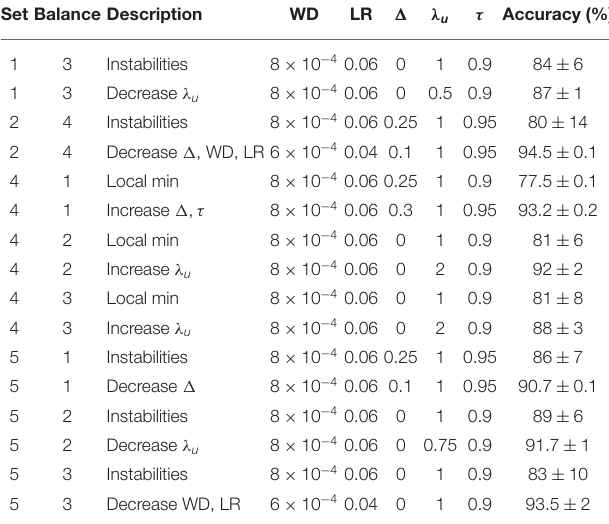
TABLE 4 | Illustration of the sensitivity to the hyper-parameters WD, LR, 1 , λ u , and τ . See the text for guidance on how to tune these hyper-parameters for situations with inferior performance due to instabilities or local minimums.